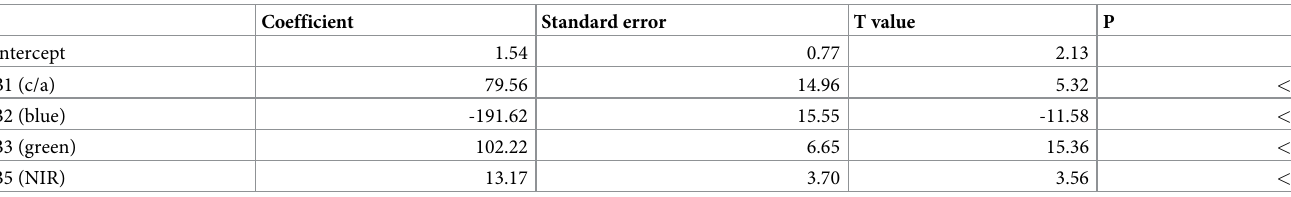
Table 4. Descriptive statistics of coefficients of the best-fitted